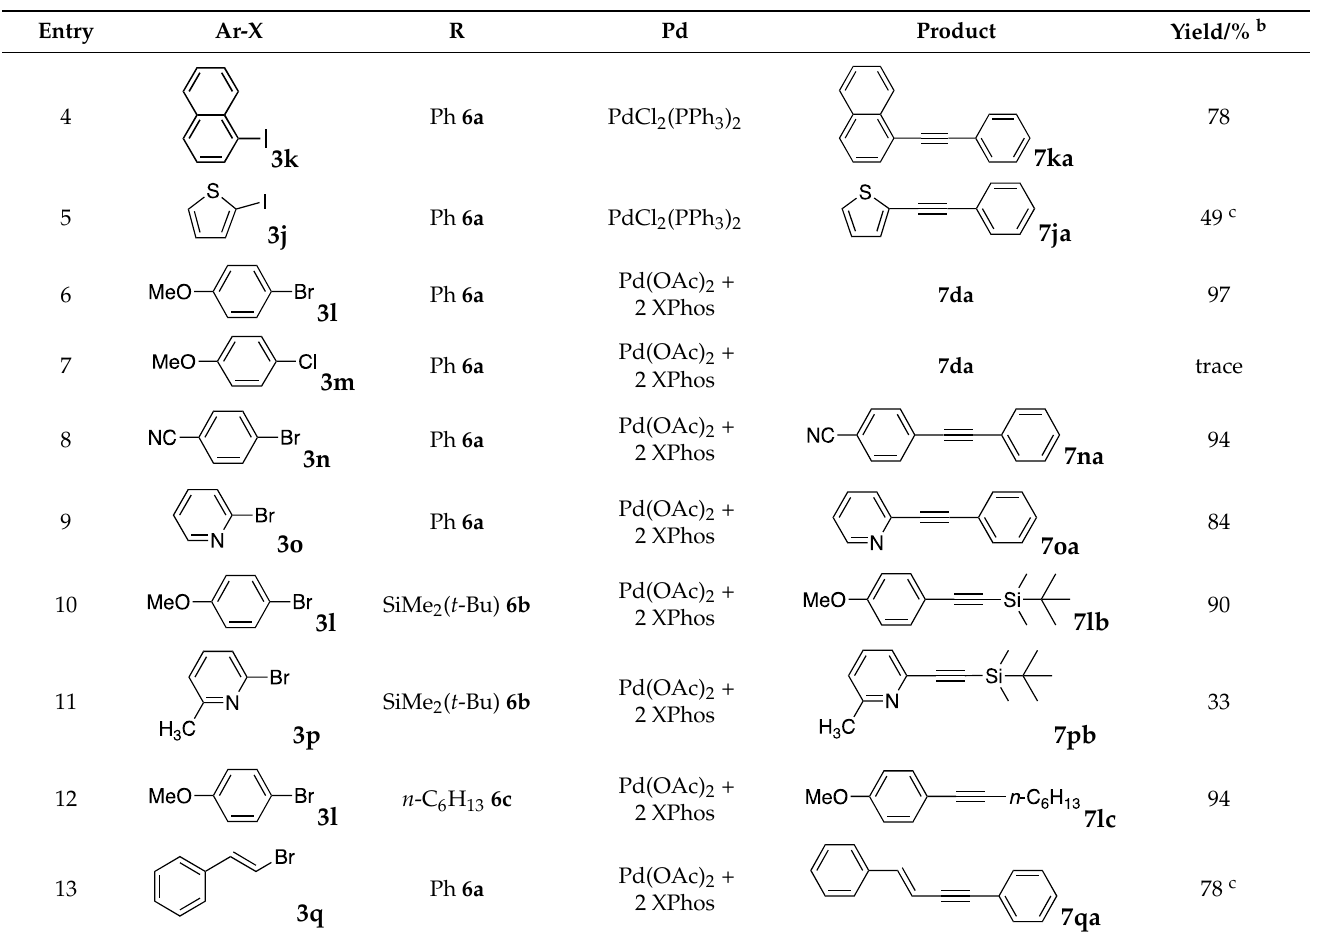
( d ) Figure 5. The appearance of the reaction mixture of Sonogashira coupling with NS . ( a ) The aqueous polymer solution. ( b ) Before the reaction with substrates. ( c ) During the reaction. ( d ) Cooled after the reaction with precipitated chunks. We then investigated the scope and limitations of the substrates in Sonogashira cou- pling reactions using NS as thermoresponsive micelles (Table 7). Aryl iodides bearing ei- ther electron-donating or electron-withdrawing groups gave the coupled products with good yields (entries 1 and 3), although aryl bromide gave the product in a low yield with PdCl 2 (PPh 3 ) 2 (entry 2). Pd(OAc) 2 with XPhos, on the other hand, successfully promoted the reaction of aryl bromides (entries 6, 8–10, 12), except for the reaction between 2-bromo- 6-methylpyridine and ( tert -butyldimethylsilyl)acetylene (entry 11). The reaction of aryl chloride was disappointing (entry 7). It was demonstrated that Pd(OAc) 2 /XPhos was ef- fective as a catalyst in water for various aryl bromides, including alkenyl bromide (entry 13), and terminal alkynes.[82] On the contrary to the Mizoroki–Heck reactions, het- eroarenes such as 2-iodothiophene and 2-bromopyridine gave the coupling products in moderate to good yields (entries 5, 9 and 11). Table 7. Copper-free Sonogashira coupling in water using thermoresponsive copolymers a .